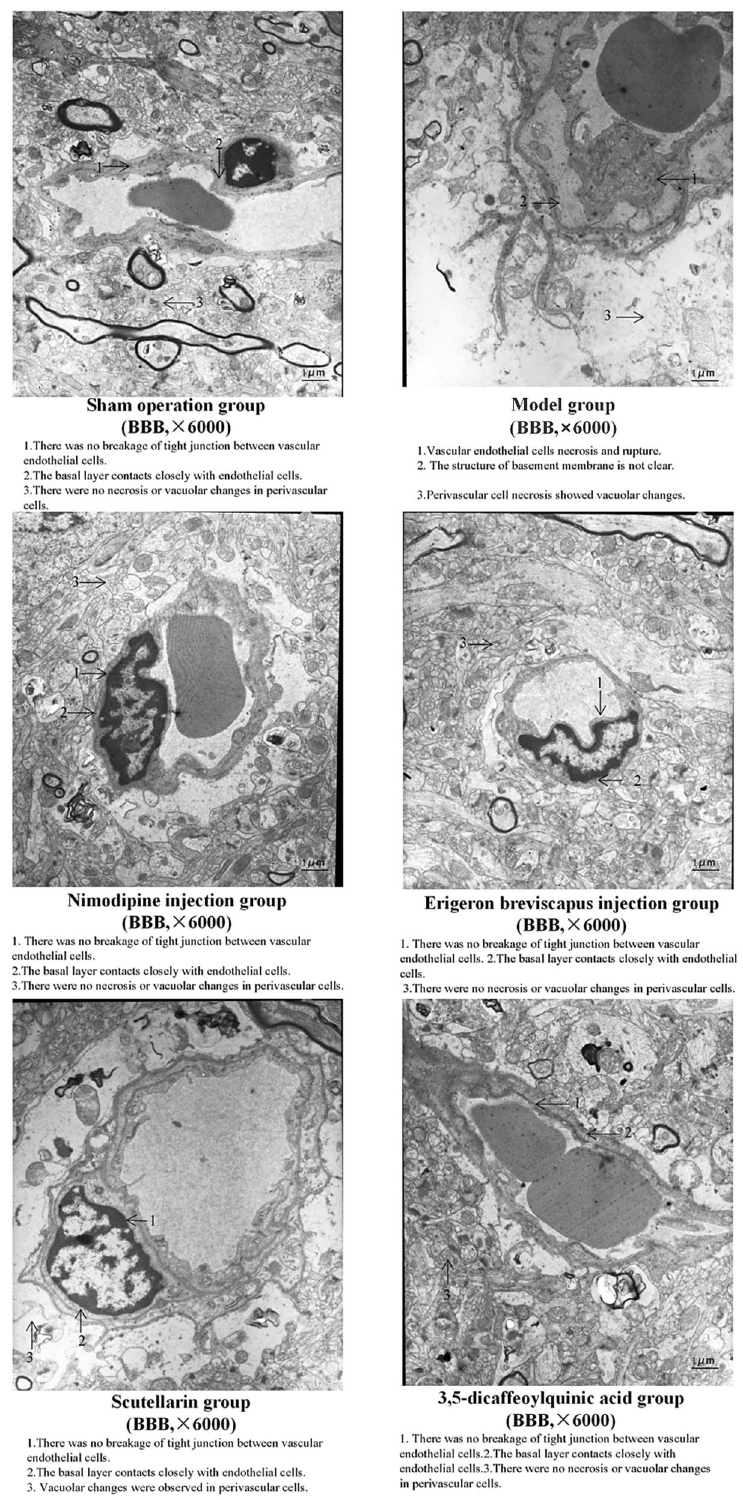
Figure 11. Ultrastructure of the BBB in the ischemic brain tissue of